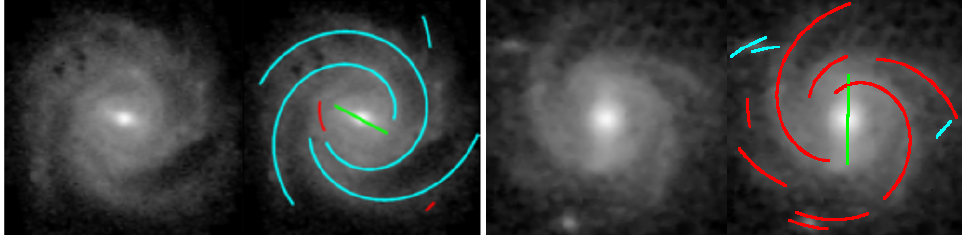
Figure 1. Two typical spiral galaxies along with SpArcFiRe’s fit to each. These two galaxies have arms that wind in opposite directions as viewed from Earth. The directions are conventionally called S-wise ( left ) and Z-wise ( right ), since the arms wind in the same direction as those letters [8]. SpArcFiRe [9] depicts S-wise arm segments as cyan and Z-wise arm segments as red, while bars are depicted in